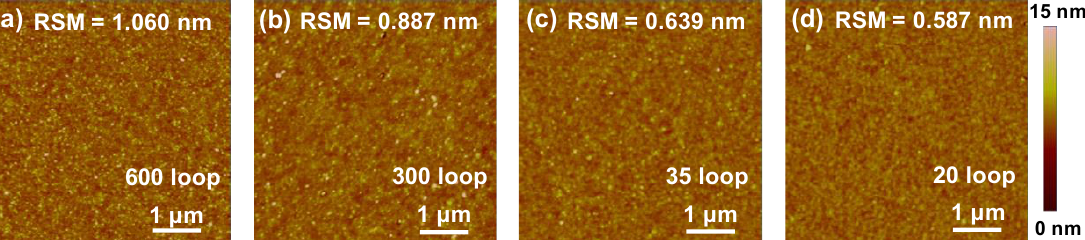
Figure 8. The AFM images of 2-nm-thick BN films grown by four FME modes: ( a ) NH 3 /TEB, ( b ) NH 3 /Itrp/TEB, ( c ) NH 3 /TEB/Itrp, ( d ) NH 3 /Itrp/TEB/Itrp.